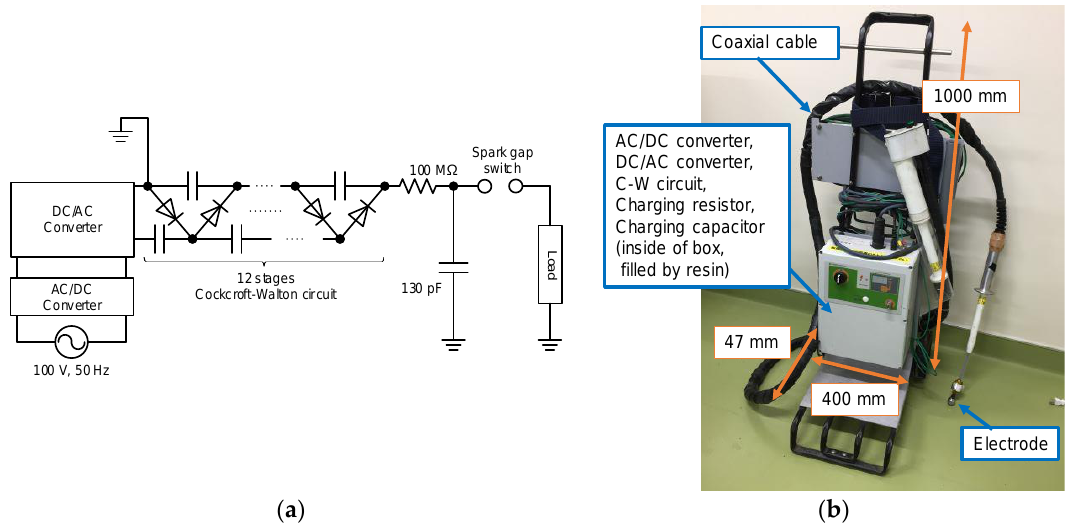
Figure 1. Circuit diagram ( a ) and photograph ( b ) of C-W circuit.